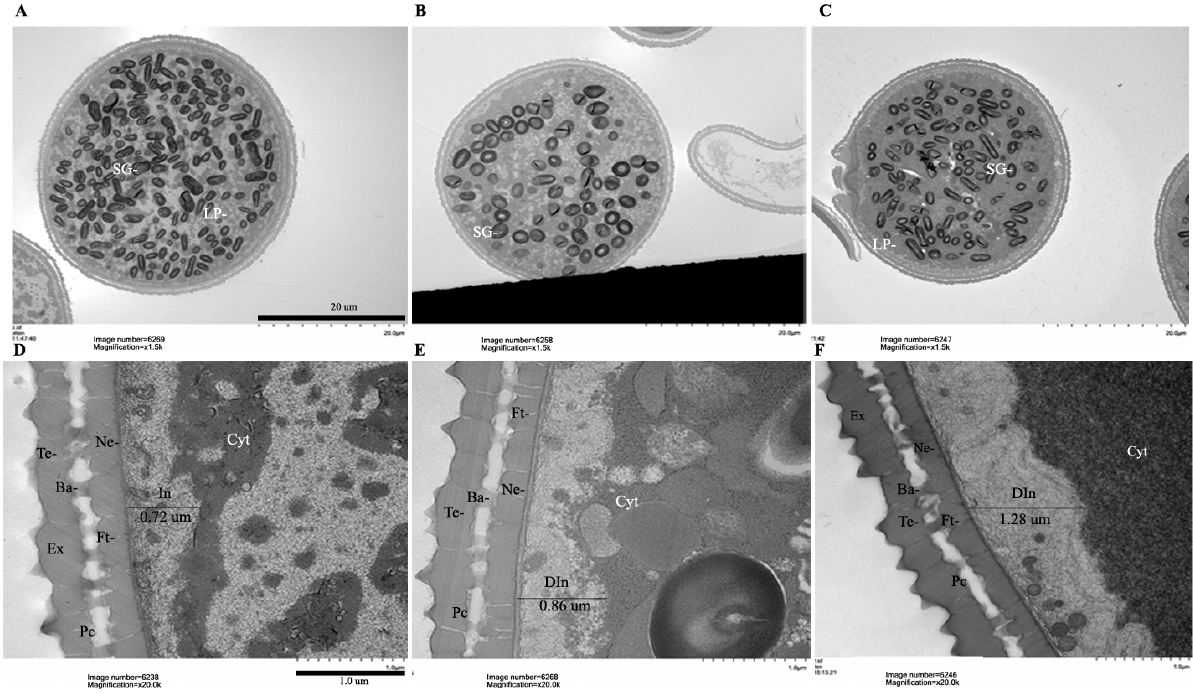
Figure 6. Transmission electron microscopy (TEM) examination of wild-type (WT) and OsRACK1B- OX transgenic pollen grains during anther dehiscence stage. ( A – C ) TEM image showing that the WT pollen grain ( A ) contains a larger number of starch granules than OX-1 ( B ) and OX-2 ( C ) pollen. ( D – F ) Higher magnification of the pollen wall showing normal pollen wall from the WT ( D ) and the abnormality of the pollen wall in OX-1 and OX-2 mutants ( E , F ). ( D ) A higher magnification TEM image of the normal pollen wall from ( A ). ( E ) A higher magnification image of the defective pollen wall from ( B). ( F ) A higher magnification image of the pollen wall from ( C ). SG, starch granules; LP, lipid bodies; Ba, bacula; Ne, nexine; Cyt, cytoplasm; Ex, exine; In, intine; Din, defective intine; Pc, pollen coat; Ft, foot layer; Te, tectum; bars = 20 µm in ( A – C ), 1 µm in ( D – F ).